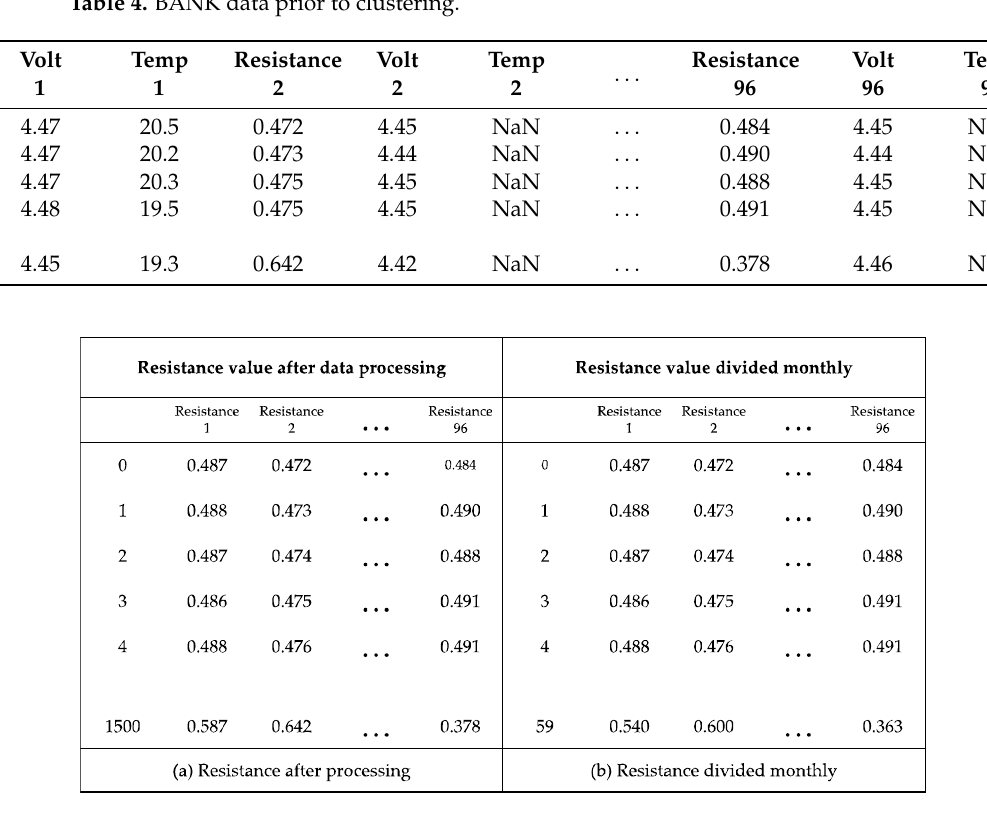
Figure 5. Results of processing clustering.